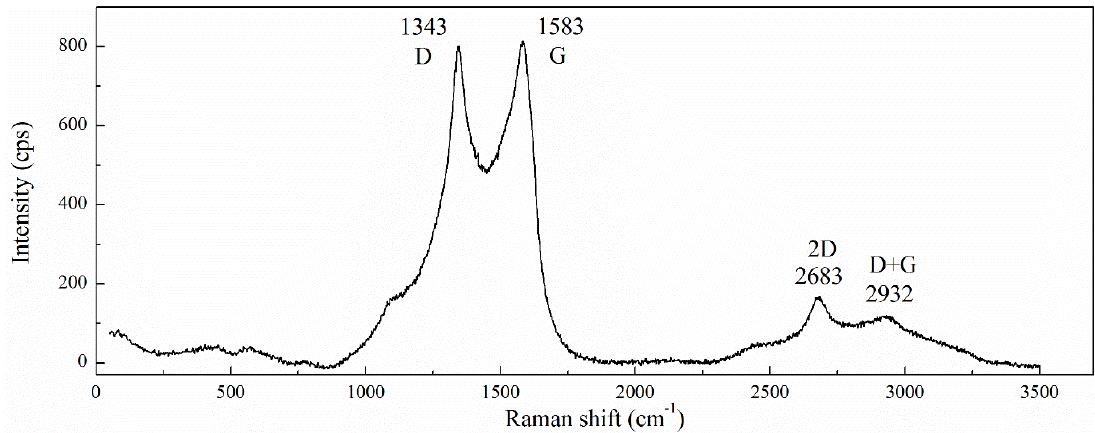
Figure 3. Raman spectra of GO.